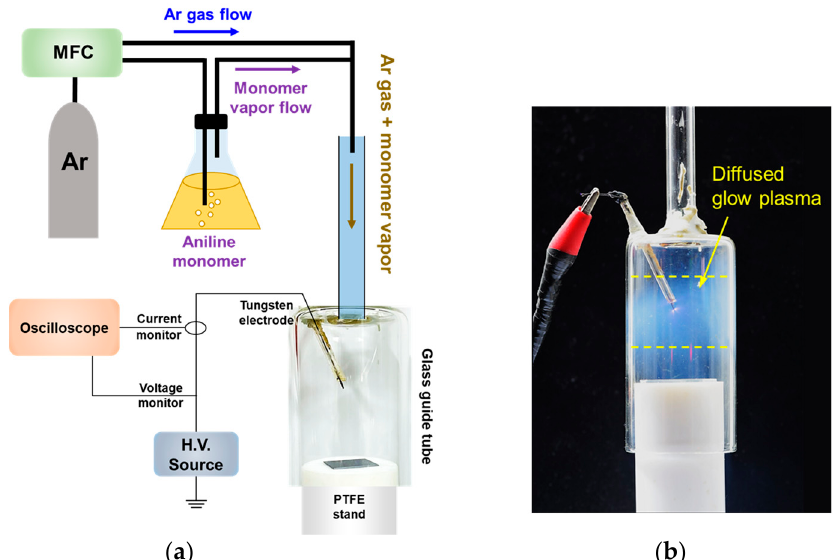
Figure 1. The atmospheric pressure (AP) plasma polymerization setup employed in this study: ( a ) schematic diagram of the AP-plasma polymerization system and ( b ) photograph of the AP-plasma reactor during plasma polymerization.